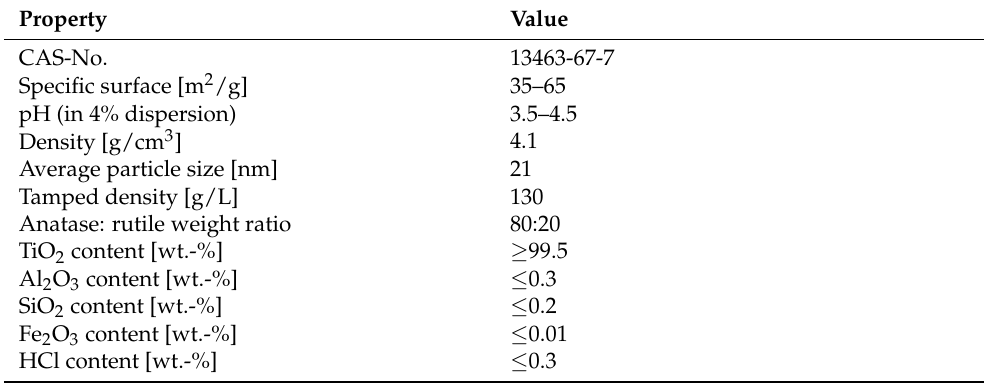
Table 1. Properties of the Aeroxide P-25